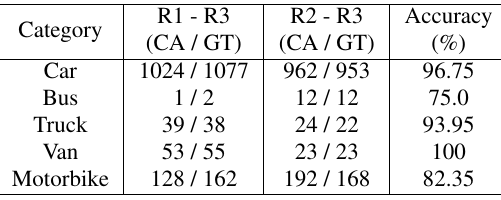
Table 3. The framework results of scenario 2.